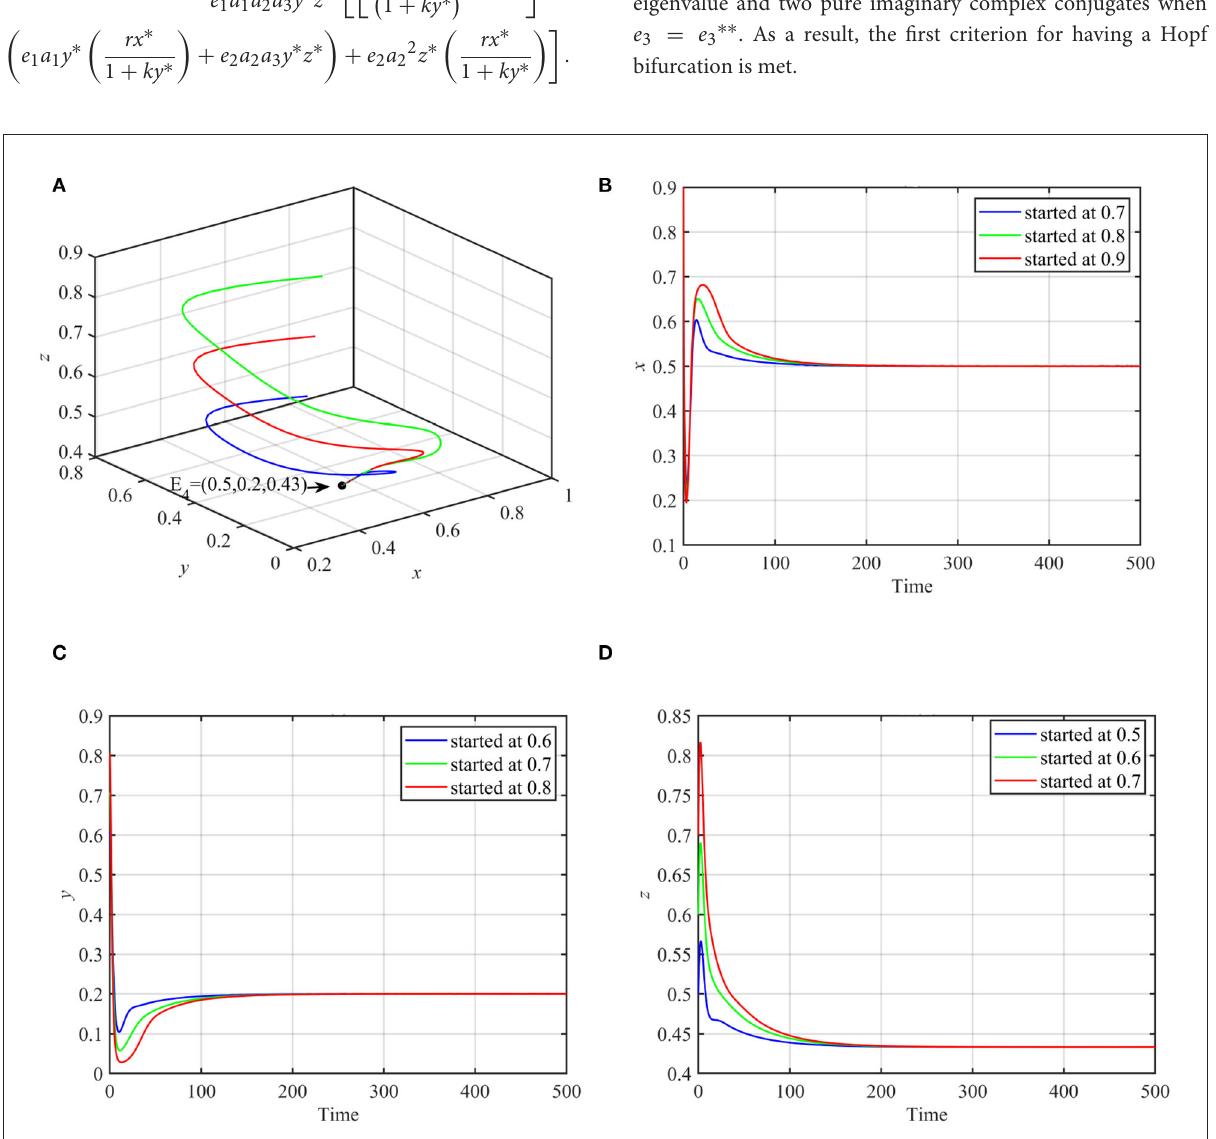
FIGURE1 Globally asymptotically stable coexistence equilibrium point using data (17) and multiple initial conditions. (A) 3D-Phase portrait of the system (1). (B) Time series for trajectories of x . (C) Time series for trajectories of y . (D) Time series for trajectories of z .